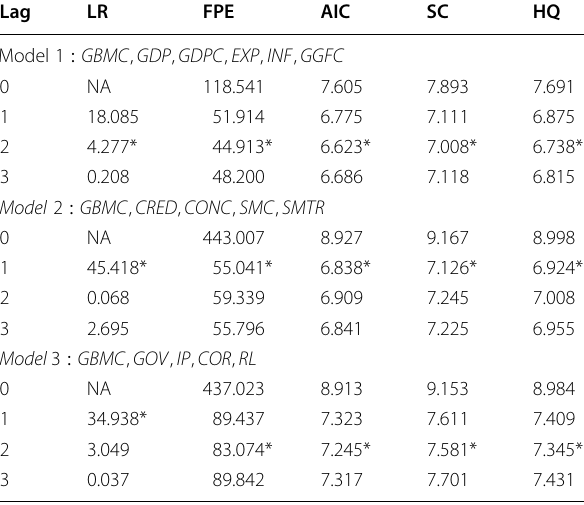
Table 3 VAR models for optimal lag selection